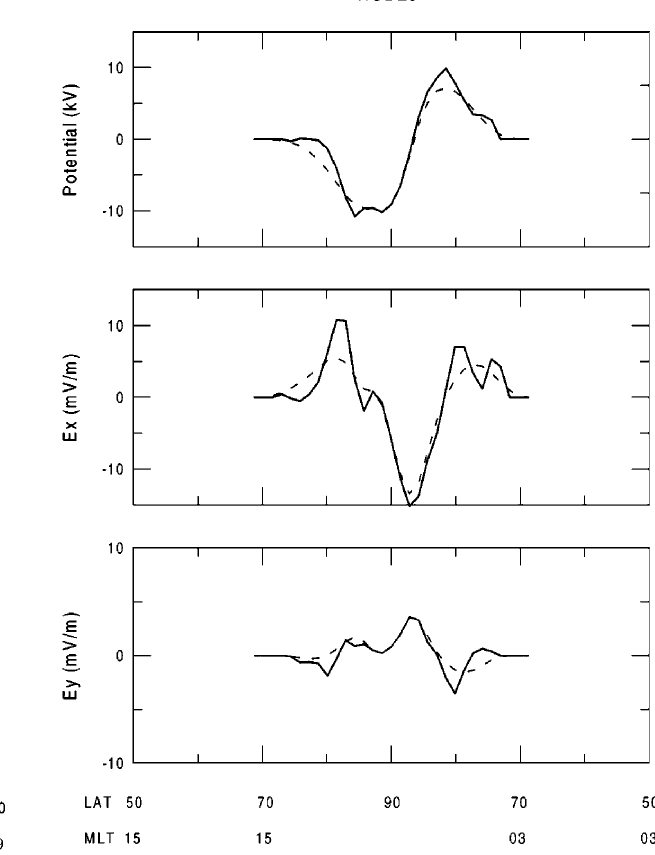
Fig. 7. Profiles of the electric potentials and electric field components ( E x and E y ) in the northern summer polar cap for IMF B x (cid:136) 0, B y (cid:136) 0, B z (cid:136) 5 nT along the MLT meridian 15-03. Solid lines are for the data from the IZMEM/DMSP model, dashed lines represent reconstructed values